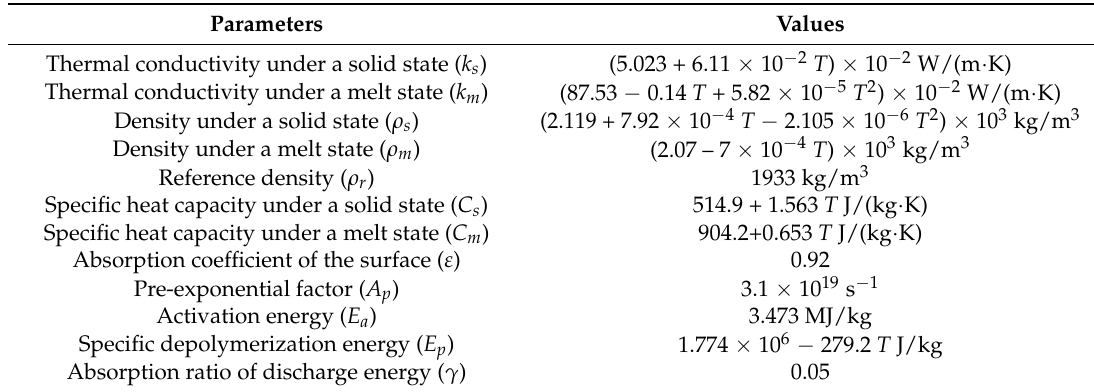
Table 1. Parameters of Teflon under different states.